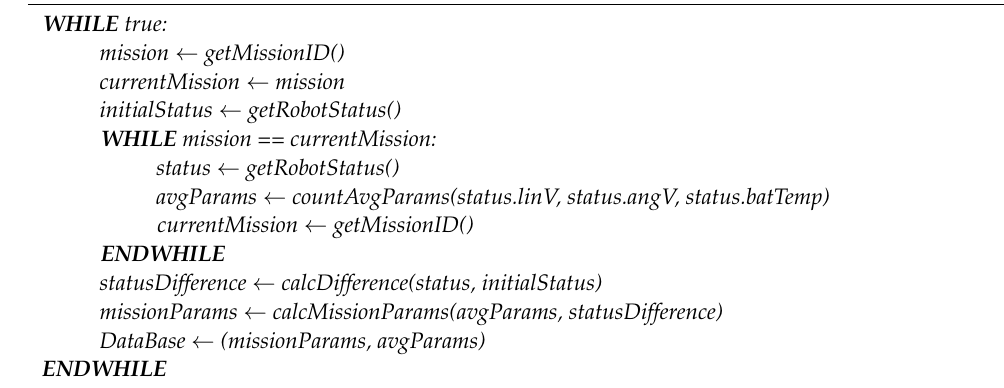
Algorithm 1: Data acquisition and analysis from each mission